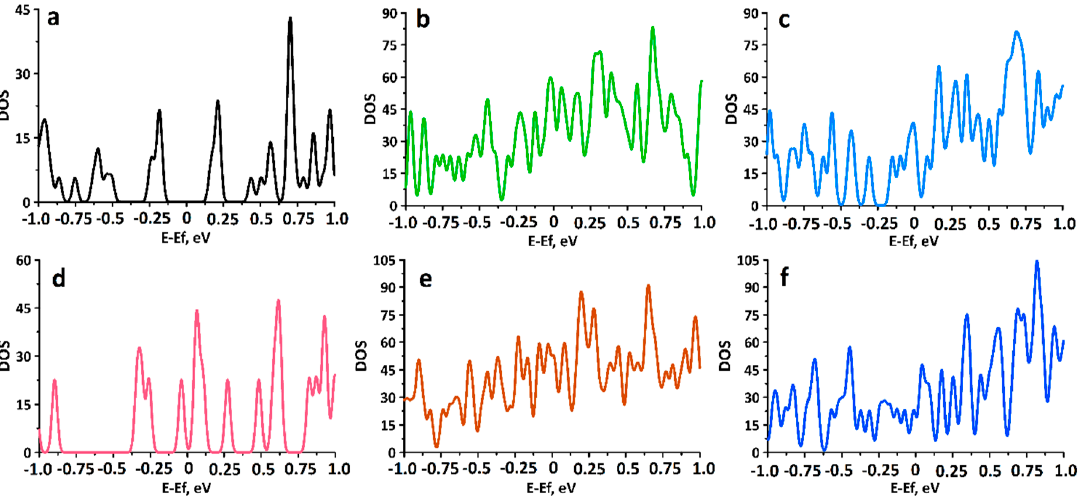
Figure 5. DOS curves of the considered structures: ( a ) pure graphene–CNT composite; ( b ) composite filled with Li; ( c ) composite filled with Na; ( d ) composite with Si; ( e ) composite filled with Si–Li; and ( f ) composite filled with Si–Na.